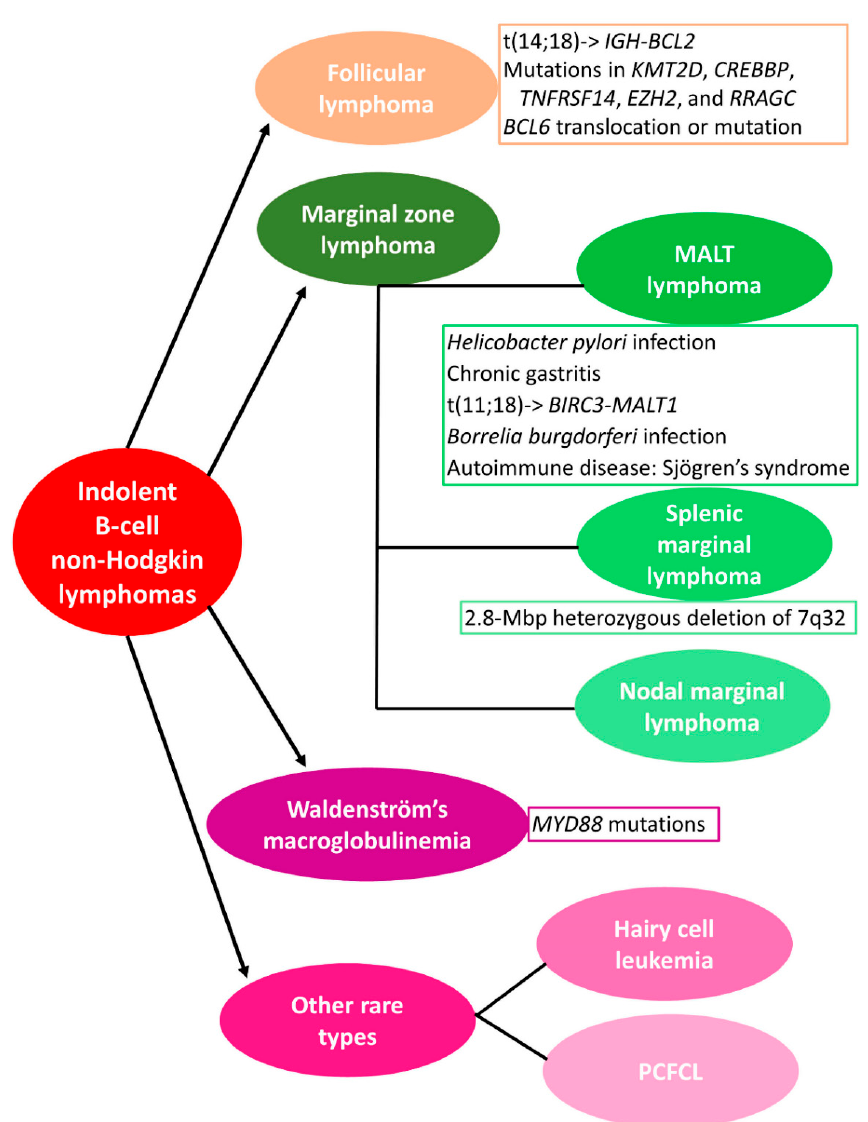
Figure 1. The main types of indolent B-cell non-Hodgkin lymphomas and some initiation factors of these malignancies. Abbreviations: MALT, mucosa-associated lymphoid tissue; PCFCL, primary cutaneous follicle center